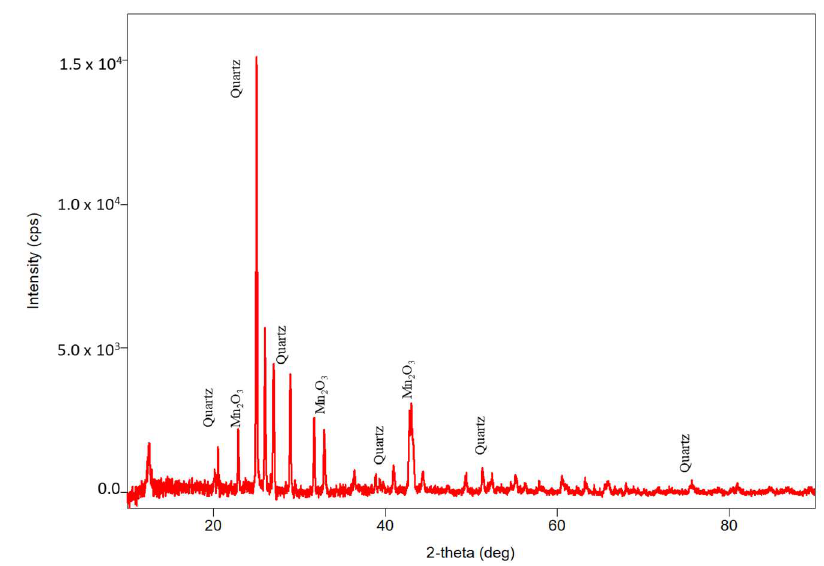
Figure 5. X-ray diffraction pattern of